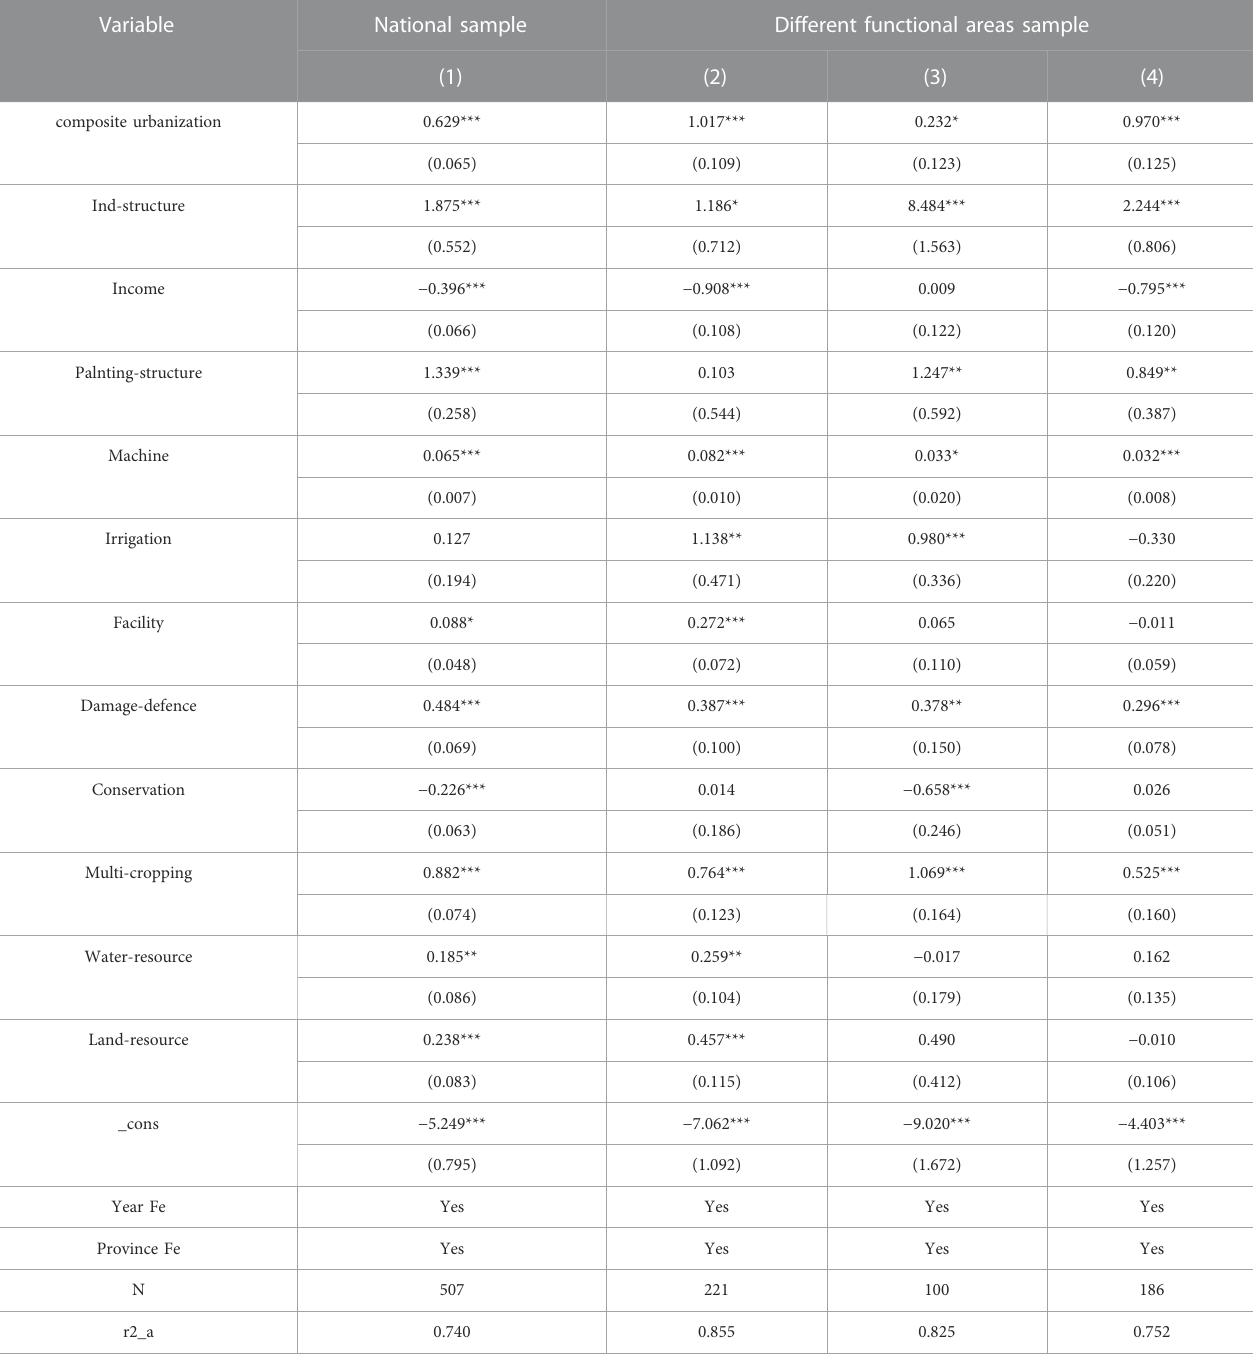
TABLE 5 Robustness test regression